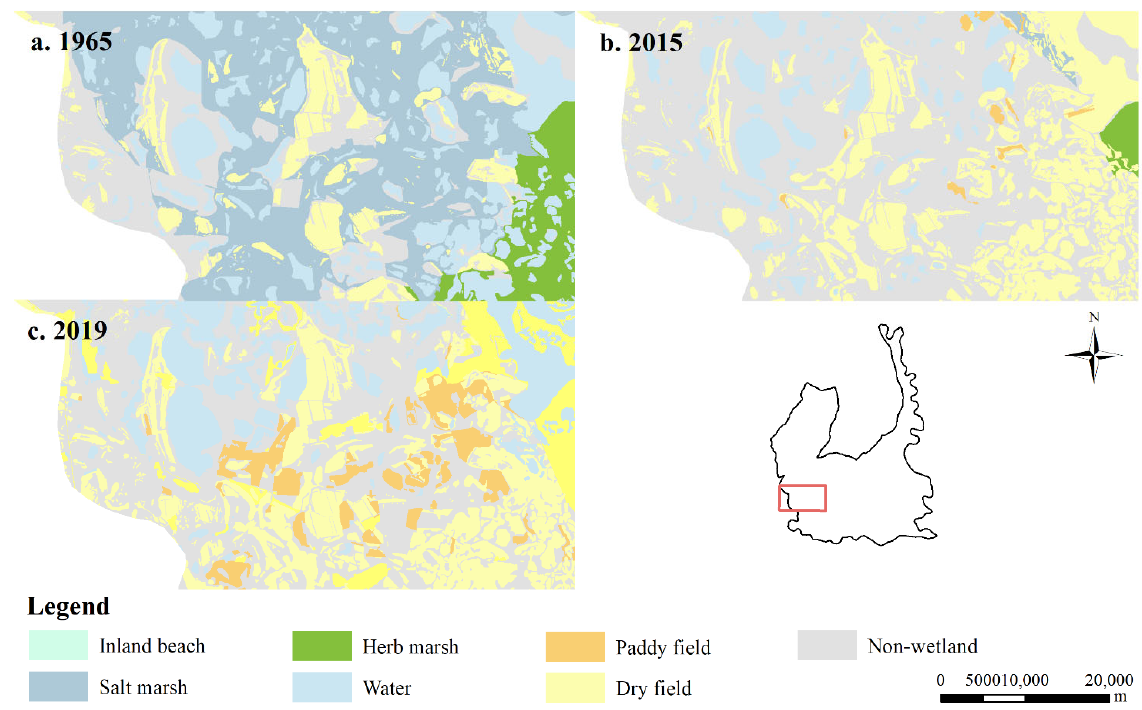
Figure 6. Maps of typical narrow wetland changes from 1965 to 2019.